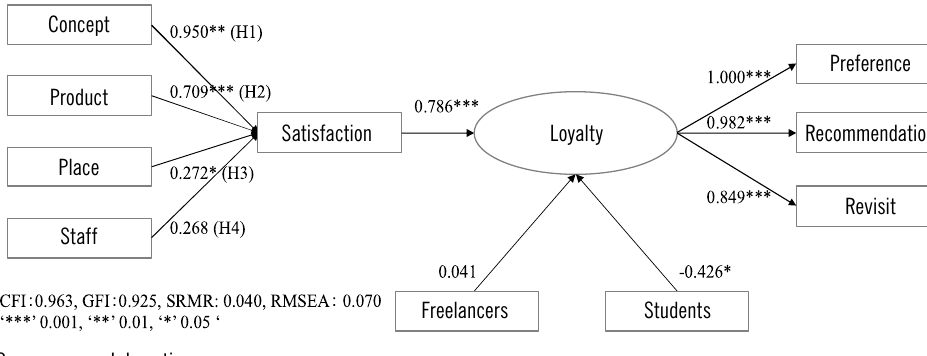
Figure 3. Result of the structural equation modeling